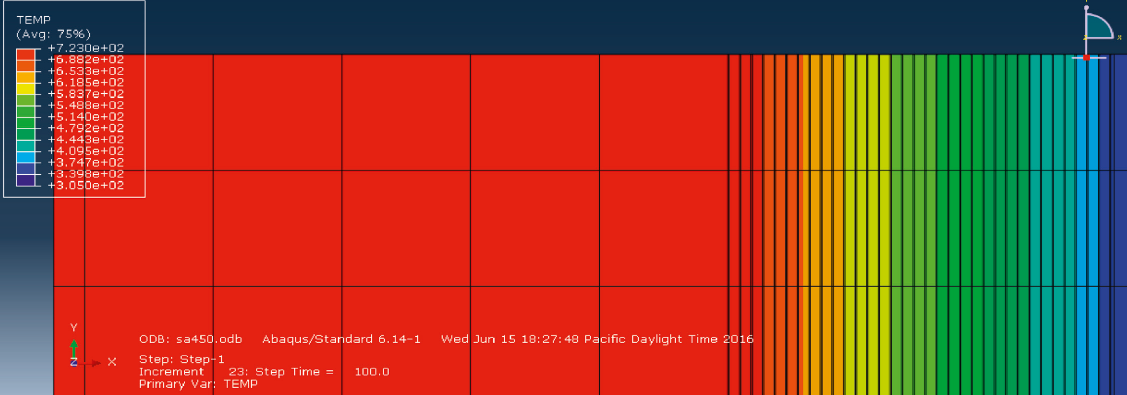
Figure 15: Convective heat flow through the CS pipe and the concrete layer.